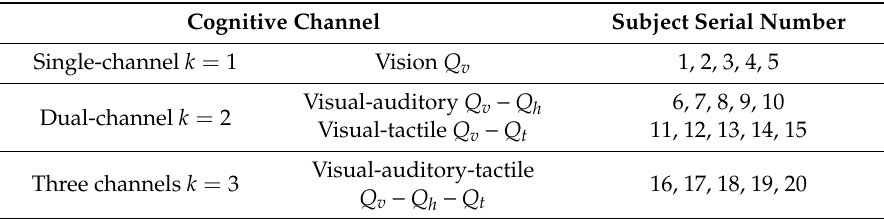
Table 1. Testers distribution table.